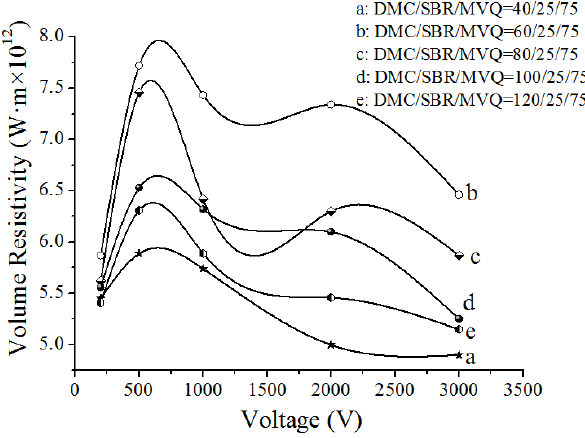
Figure 5: Volume resistivity of DMC/SBR/MVQ